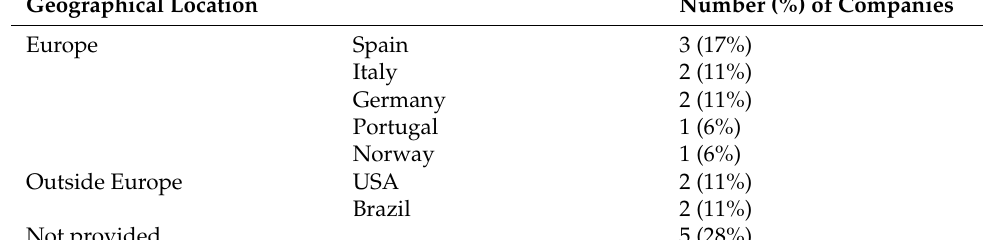
Table 1. General characteristics of the 18 companies that participated in the study.